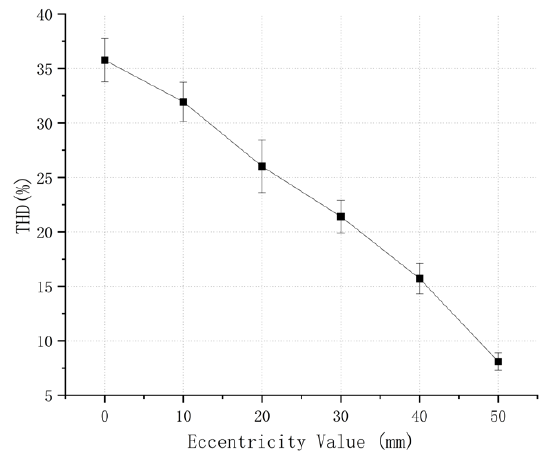
Figure 6. The THD with the air-gap magnetic field.